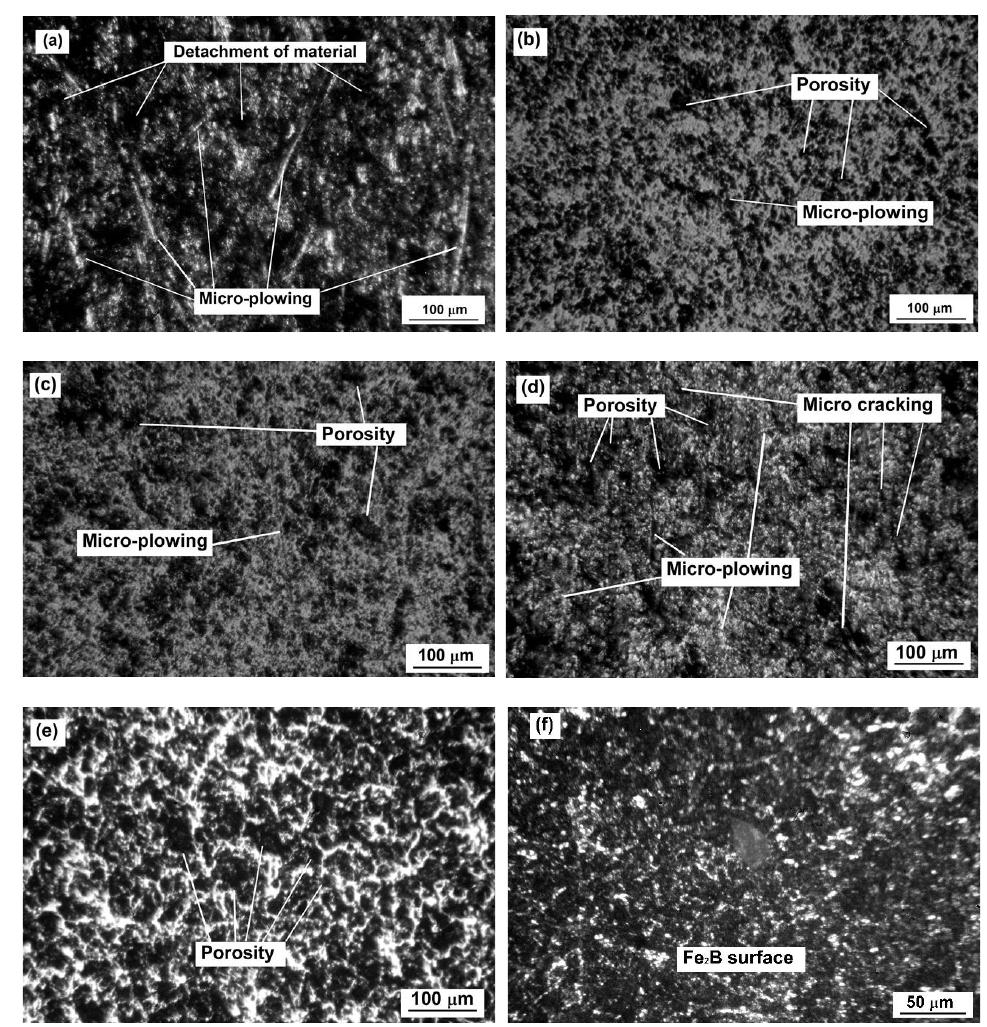
Figure 13. Wear tracks for samples 0, 3, 6, 9, and 12 ( a – e , respectively, Table 1); ( f ) is the surface of sample 12 with no wear track.